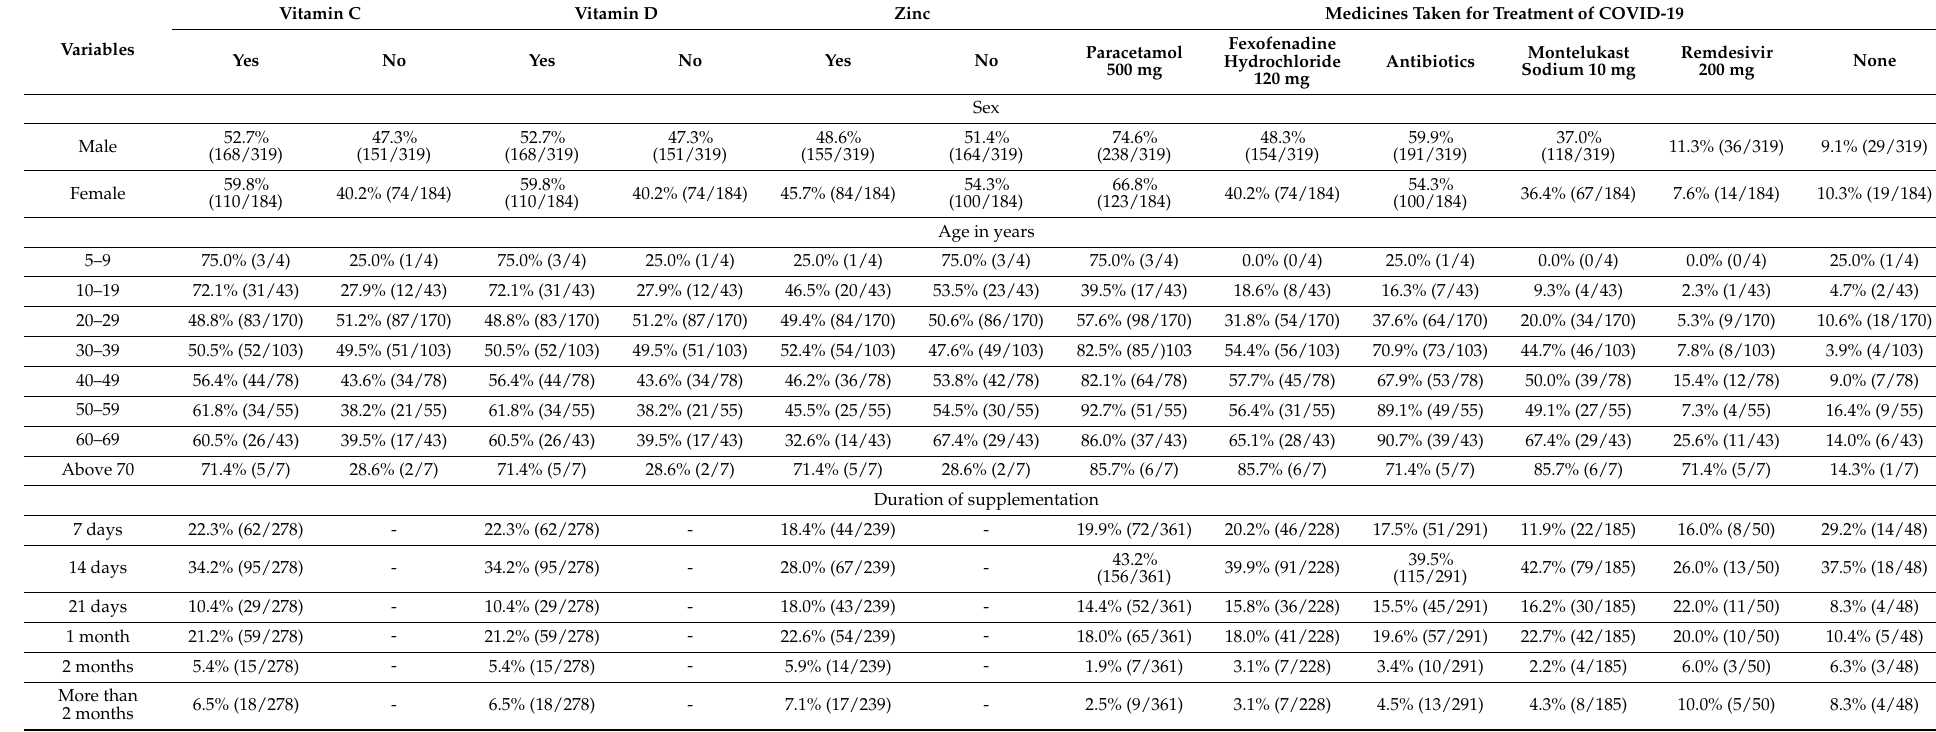
Table 2. Frequency of uptake of vitamins, supplements and medicines by COVID-positive